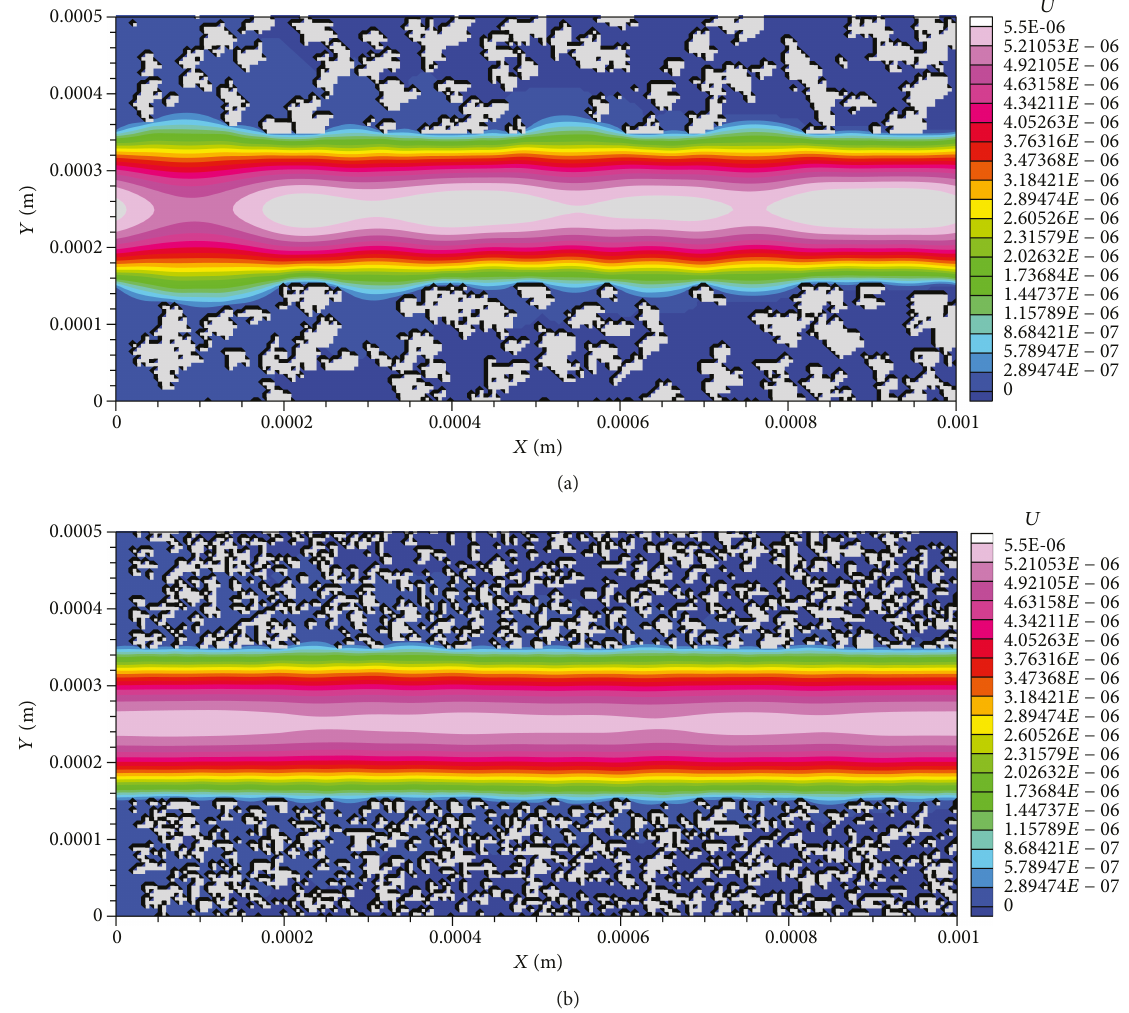
Figure 9: Velocity pro fi le (m/s) for cases with (a) coarser and (b) fi ner nonreactive minerals when Pe =26 and Da =20. In both (a) and (b), porosity (after dissolution) is near 0.56 but permeability (after dissolution) is 1.56 × 10 − 9 m 2 for (a) and 1.41 × 10 − 9 m 2 for (b).